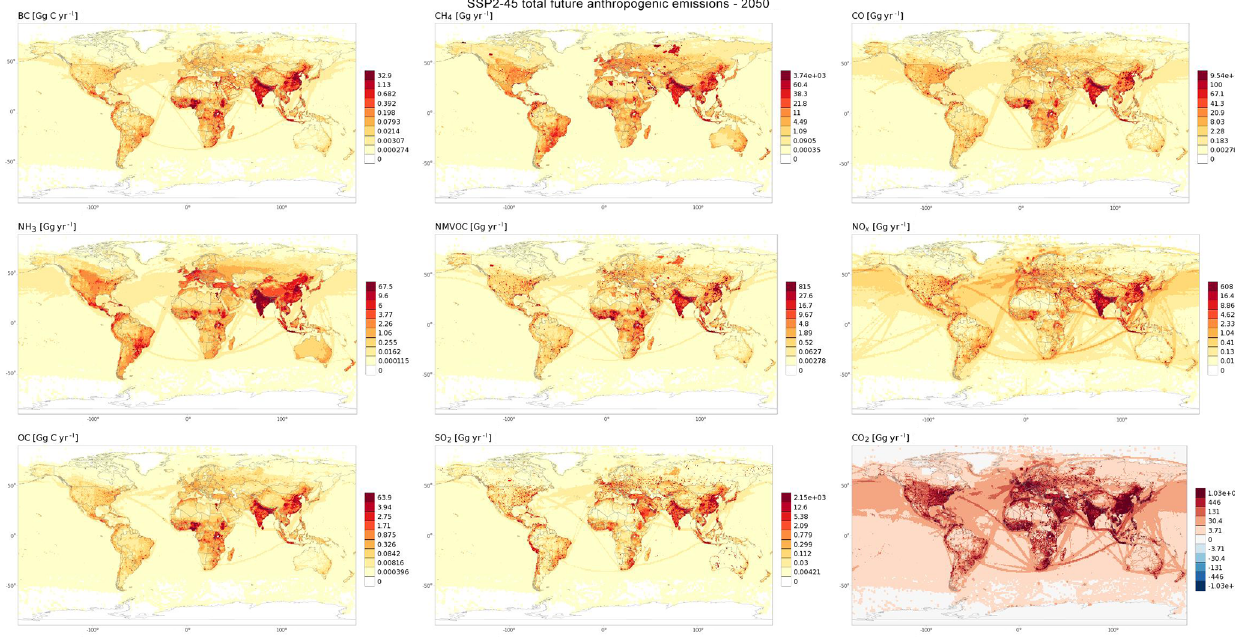
Figure 7. Total anthropogenic emissions in 2050 by species in the SSP2-45 scenario. The color scale is the same for each emission species across all gridded figures for comparison. The CO 2 color scale accommodates the net negative emissions found in some future